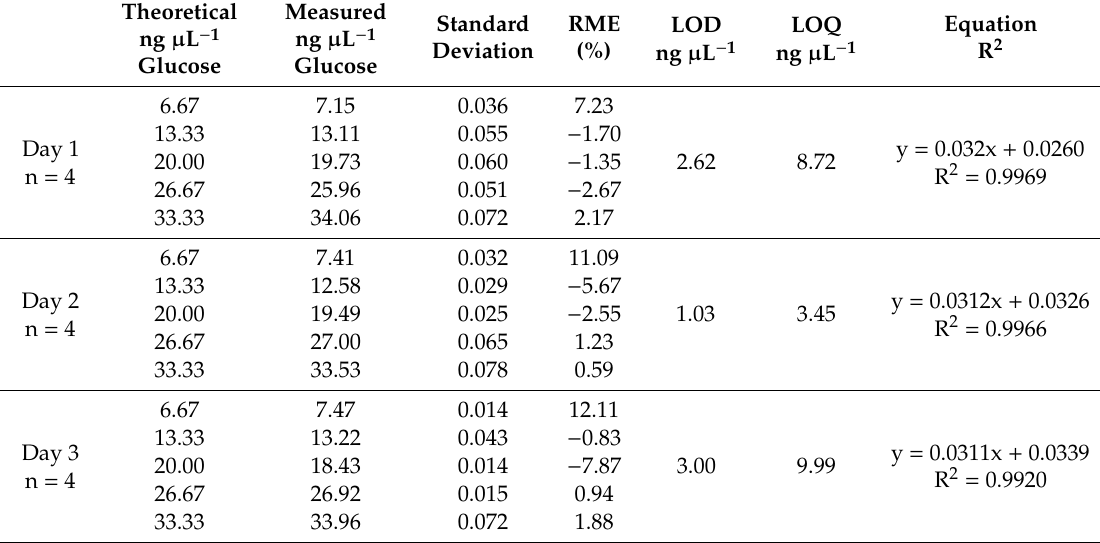
Table 5. Sensitivity and accuracy of anthrone quantification method for cellulose-derived glucose.